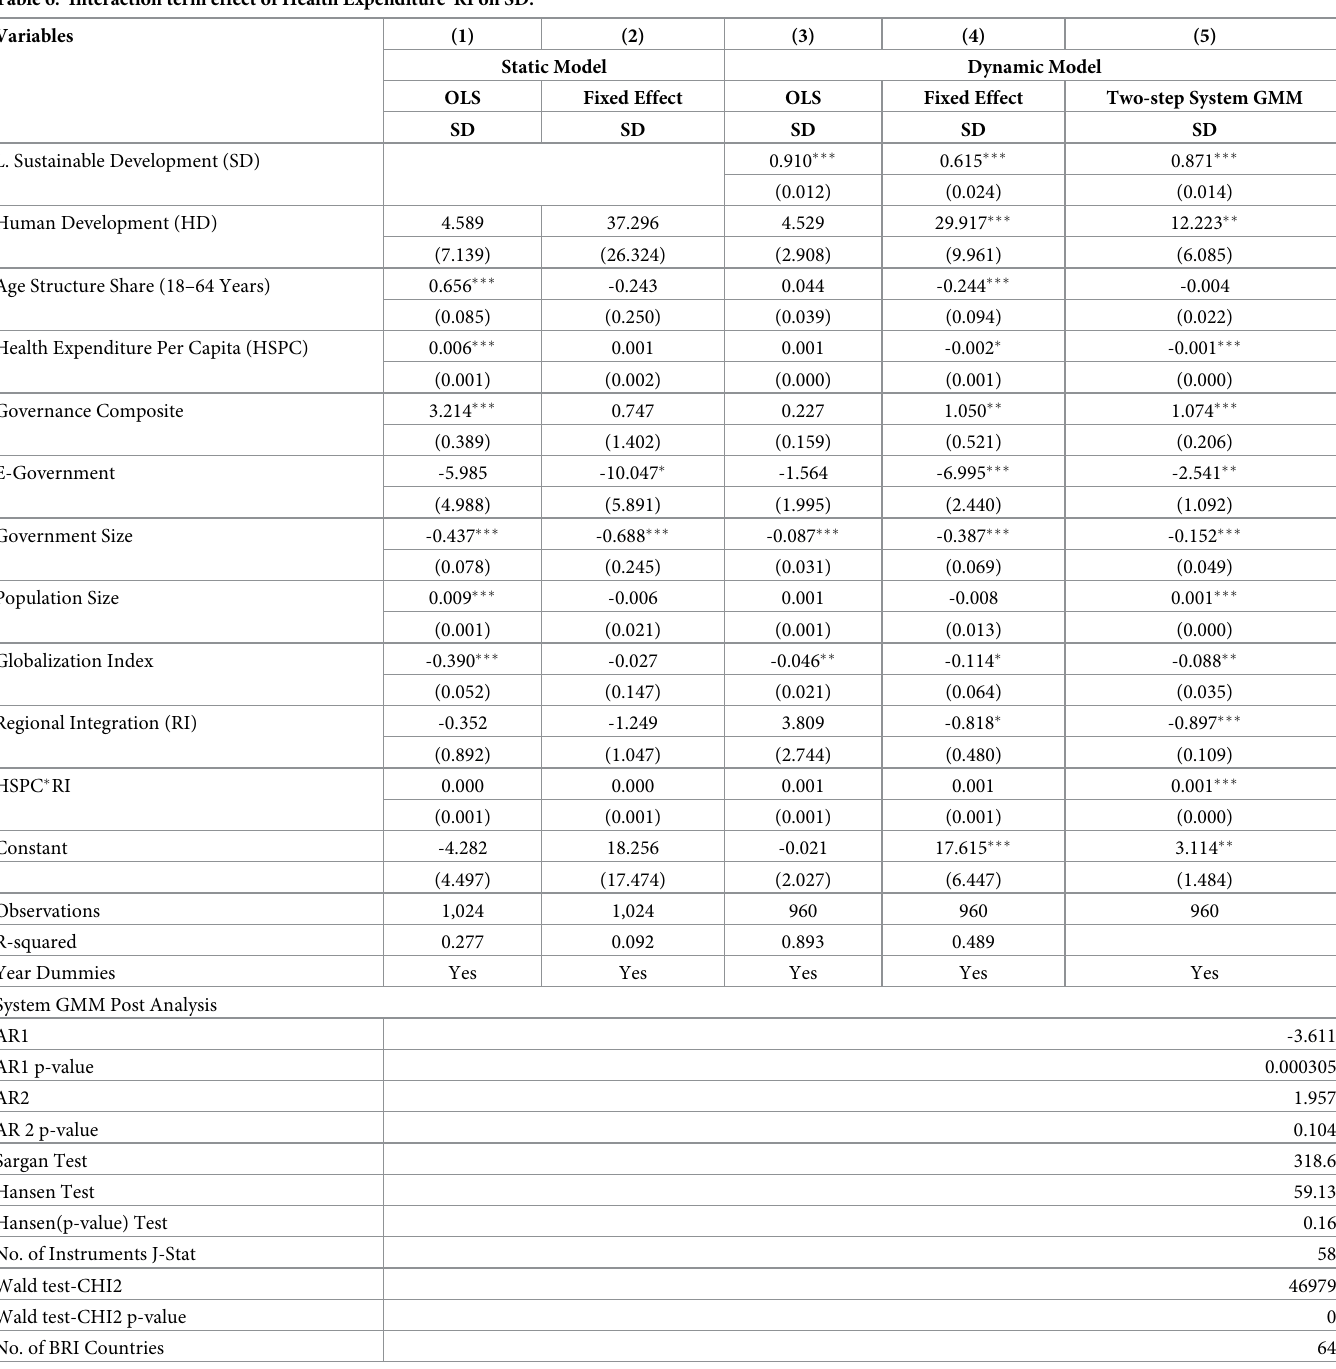
Table 6. Interaction term effect of Health Expenditure � RI on